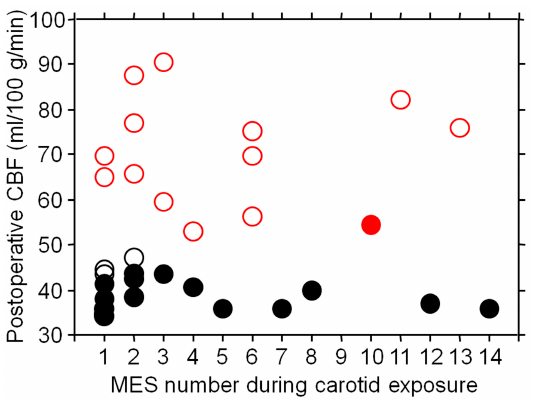
Figure 2. Relationships between the number of microembolic signals (MES), postoperative CBF (cerebral blood flow), cerebral hyperperfusion, and the development of diffusion-weighted imaging (DWI)-characterized postoperative cerebral ischemic lesions. Closed and open circles indicate patients with and without DWI-characterized postoperative cerebral ischemic lesions, respectively. Red and black circles indicate patients with and without postoperative cerebral hyperperfusion (defined as postoperative CBF increase ≥ 100% compared with preoperative values), respectively. Whereas 15 (83%) of 18 patients without postoperative cerebral hyperperfusion showed DWI-characterized postoperative cerebral ischemic lesions, only one (7%) of 14 patients with hyperperfusion had these ischemic lesions. Table 1. Univariate analysis of factors related to development of diffusion-weighted imaging (DWI)- characterized postoperative cerebral ischemic lesions.